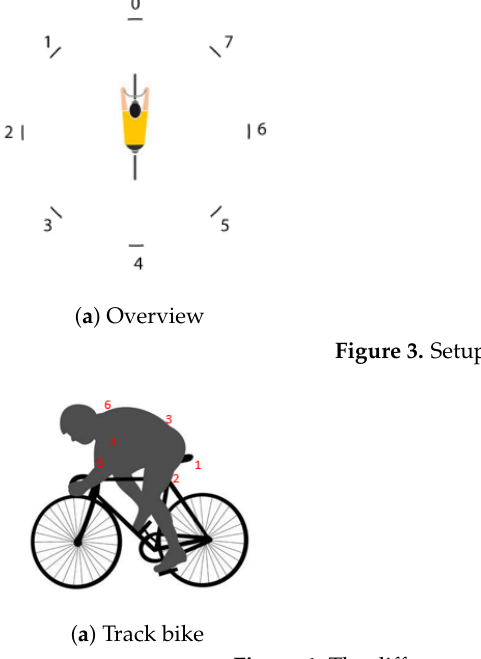
Figure 4. The different tag positions.